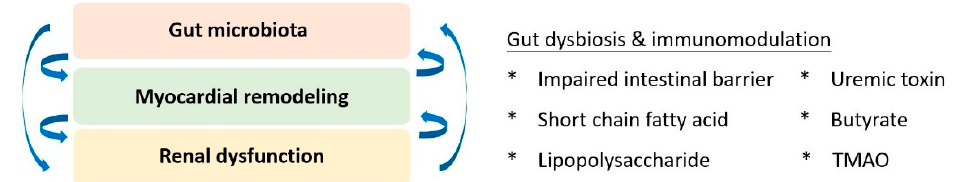
Figure 2. The gut-cardio-renal triplet. The gut microbiome and the pathophysiology of cardiac and renal systems are mutually interactive and dependent on the inflammatory response. TMAO: tri- methylamine-N-oxide.